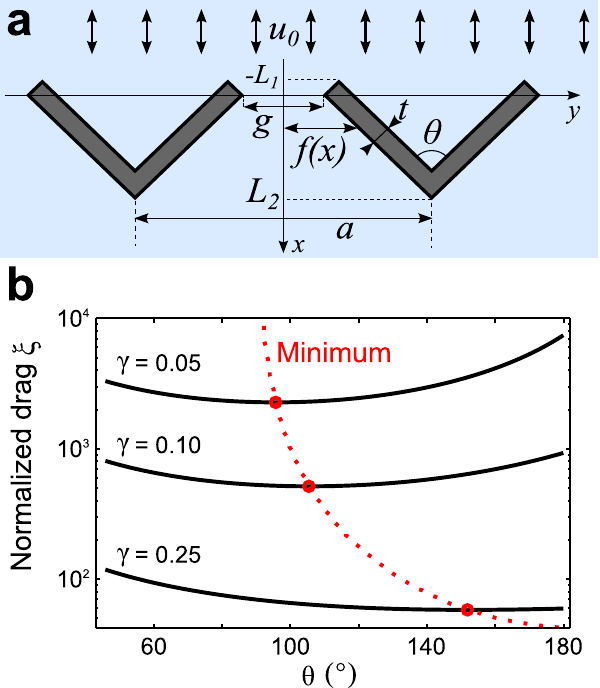
Figure 2. Analytical approximation of the normalized drag of a hair bundle in a row. ( a ) Schematic of the analyzed geometry. See text and Methods for parameters. ( b ) The drag is minimal at an optimal angle θ * (red) of the hair-bundle shape. The optimal angle shifts to larger values for increasing gap